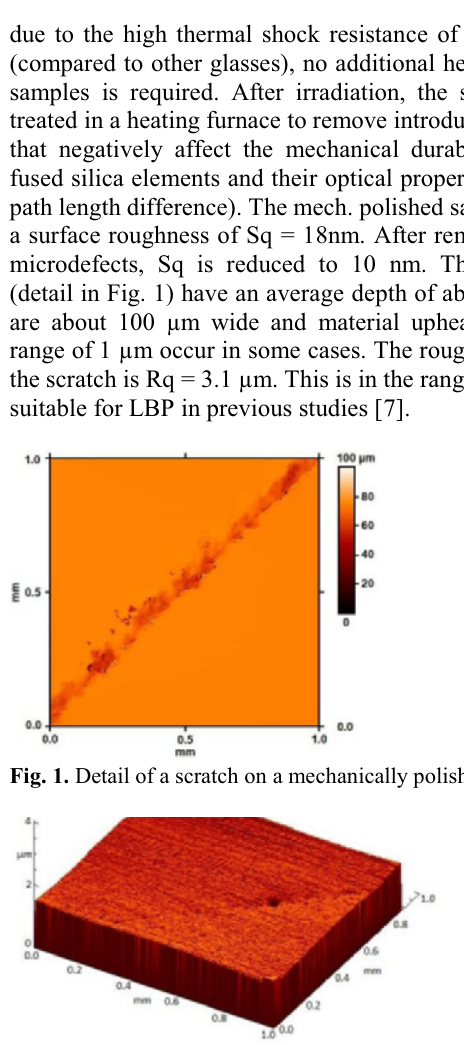
Fig. 2. Scratch, not completely removed (detail) .